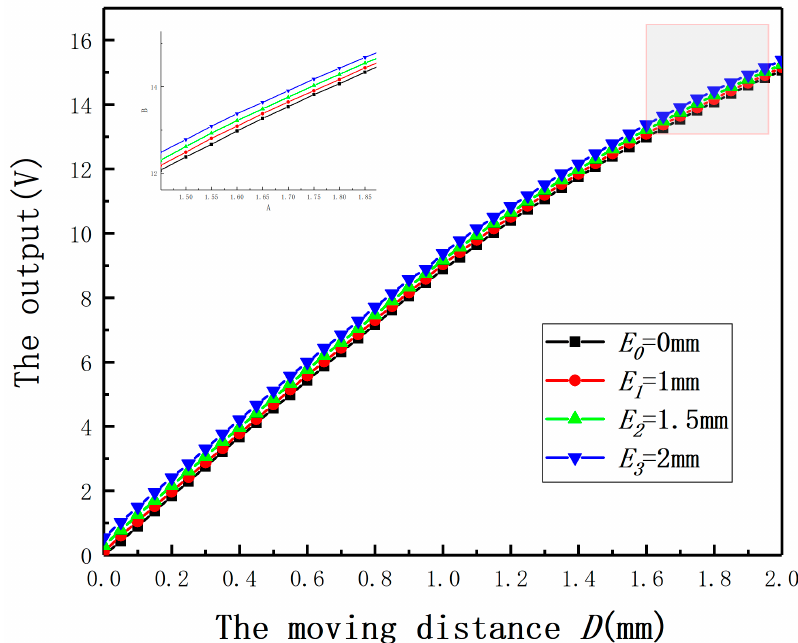
( d ) Figure 29. The output curves before and after compensation under different eccentricities: ( a ) E = 3 mm; ( b ) E = 4 mm; ( c ) E = 5 mm; ( d ) E = 6 mm. 5. Application of Compensation Method in Magnetic Suspension Motor The length of air gap has a great influence on the performance and reliability of a magnetic suspension motor. If the air gap is too large, the magnetic resistance will increase. The excitation current required to achieve the same magnetic field strength will increase greatly, and the excitation loss will also increase greatly. The power factor of the motor will decrease significantly, and the performance of the motor will deteriorate. In order to reduce the excitation current and improve the power factor, the air gap should be minimized. Generally, the air gap of a magnetic suspension motor is about 2 mm and the radial position control accuracy is 5‰. However, if the rotor radius is 30 mm, when the air gap is within 2 mm, the hardware compensation accuracy of the differential structure is